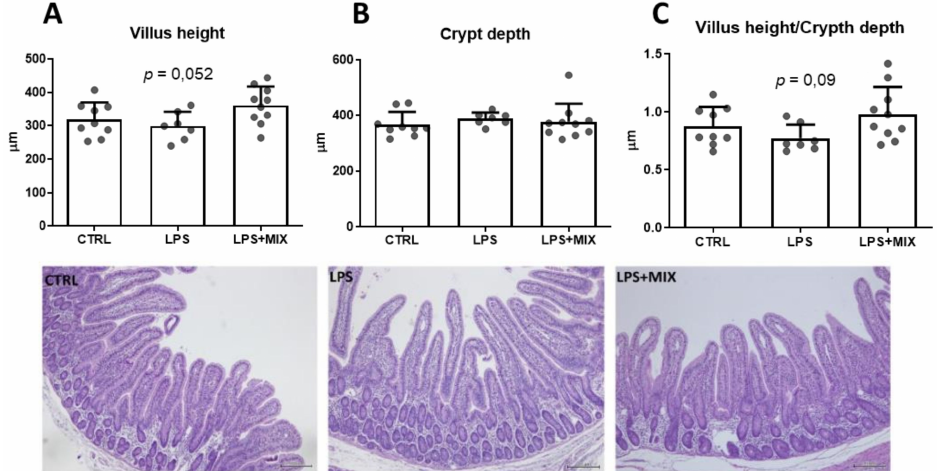
Figure 1. Gut morphology in jejunum at day 35, the end of the trial. ( A – C ) represent villus height, crypt depth and villus height/crypt depth ratio, respectively. Groups are: CTRL, the control group; LPS, the LPS-challenged group; LPS+MIX, the LPS-challenged supplemented with arginine, branched- chain amino acids (BCAA), and cystine mixture group ( n =